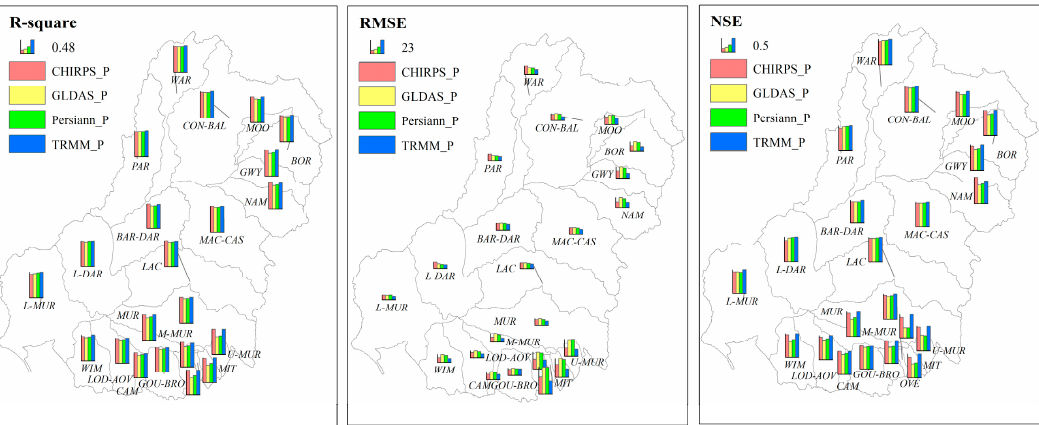
Figure 5. Bar plots showing the statistics ( R 2 , RMSE and NSE ) of monthly P estimated with CHIRPS P , GLDAS P , Persiann P and TRMM P products within the 22 catchments of the MDB when compared with the monthly AWAP P values. The embedded bar plots with numbers at the upper-left corners are the scales for interpreting the bars associated with each catchment.